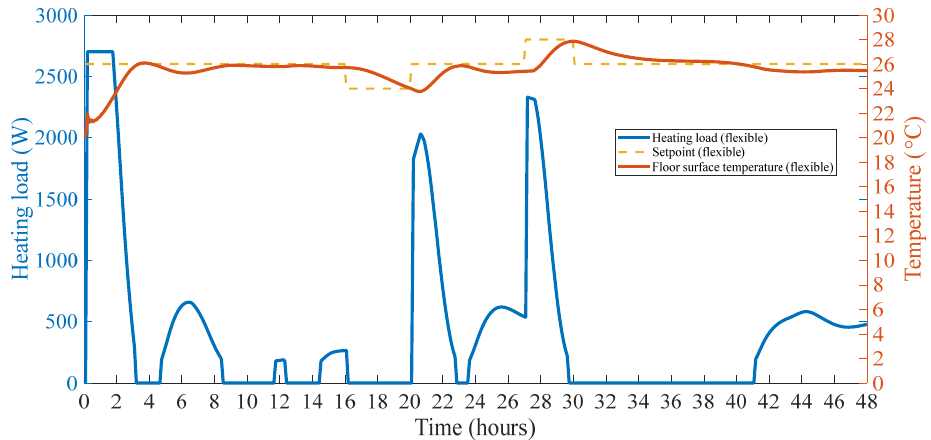
Figure 21. Flexible heating load profile for floor surface temperature control.